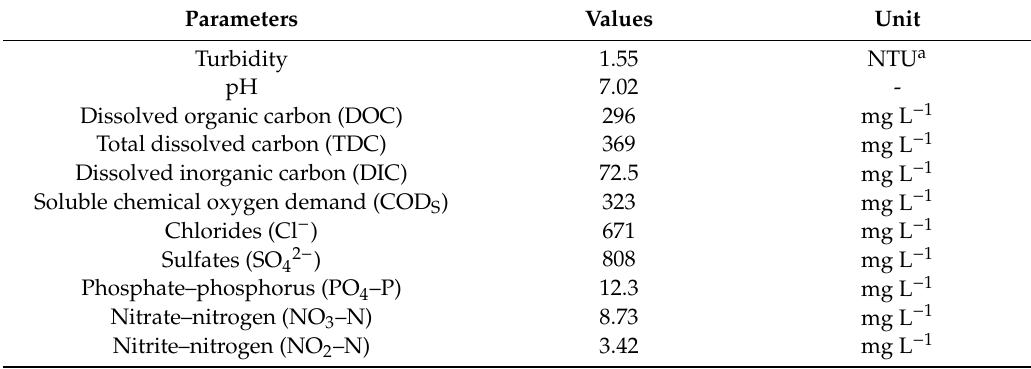
Table 1. Physicochemical characterization of the paper industry e ffl uent used in this study. Parameters Values Unit